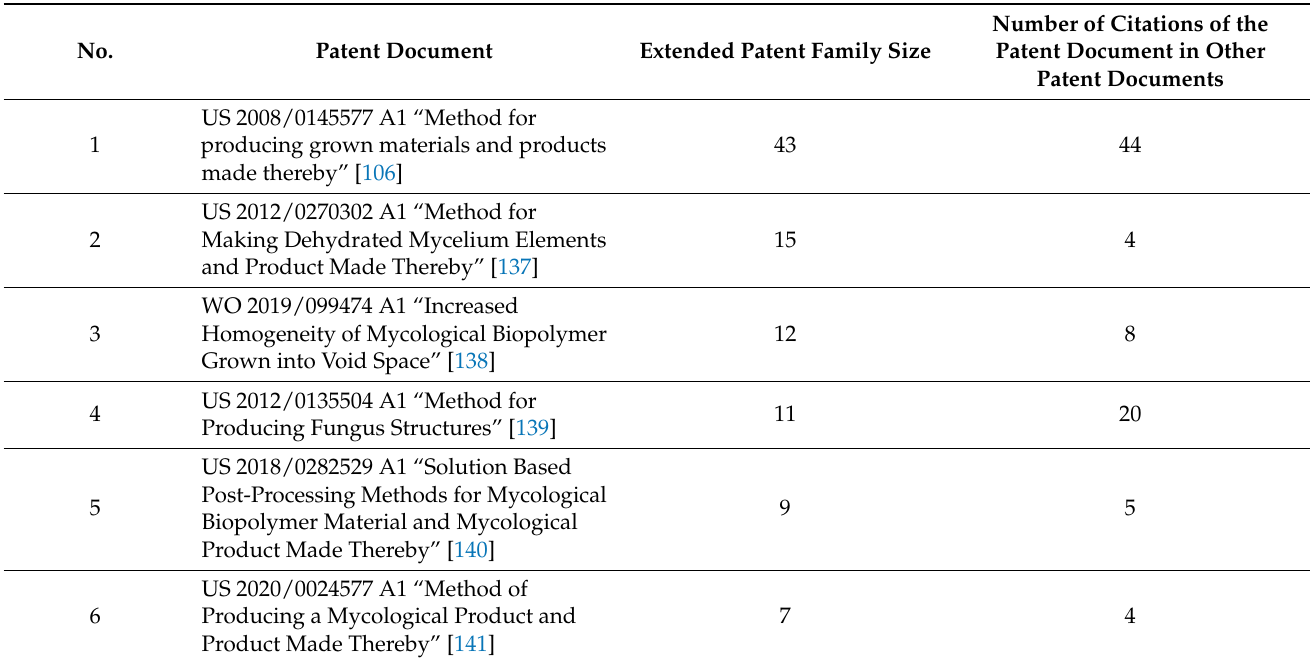
Table 5. Most influenced patent